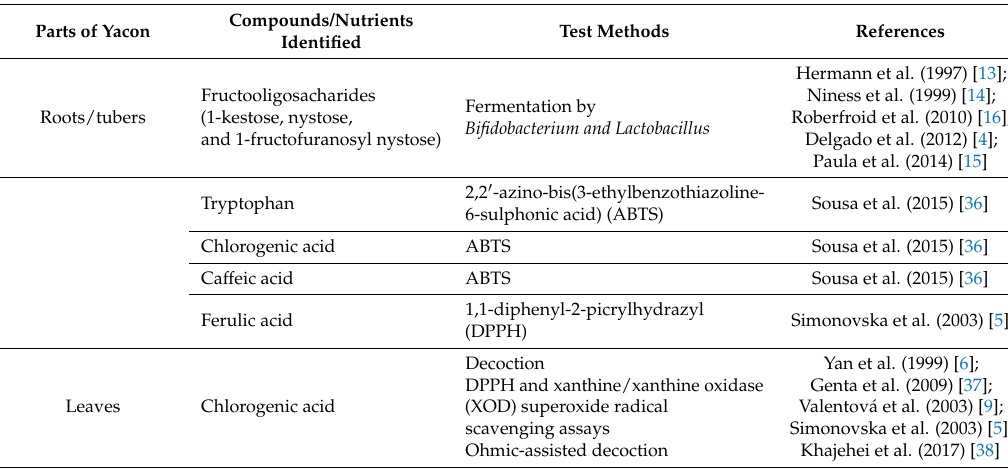
Table 2. An overview of major phytochemical compounds of